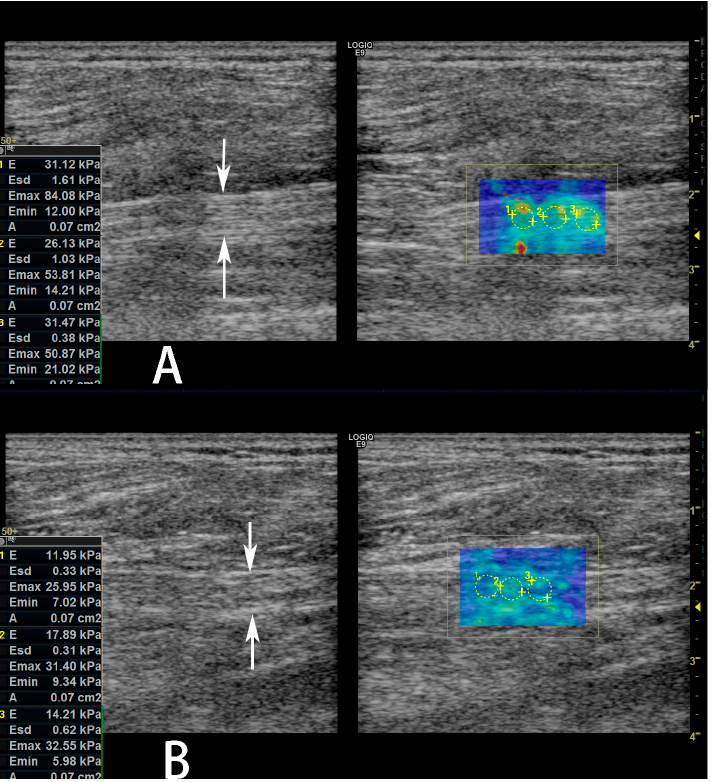
Figure 3. Shear wave elastography (SWE) images of the sciatic nerve in a 61-year-old male diabetic patient with diabetic peripheral neuropathy (DPN). He also had a diabetic foot ulcer (DFU) on the left lower limb. The average SWE stiffness value of the left sciatic nerve was 29.57 kPa ( A ), which was higher than SWE stiffness value of the sciatic nerve, average 14.68 kPa; ( B ) the right lower limb without DFU.